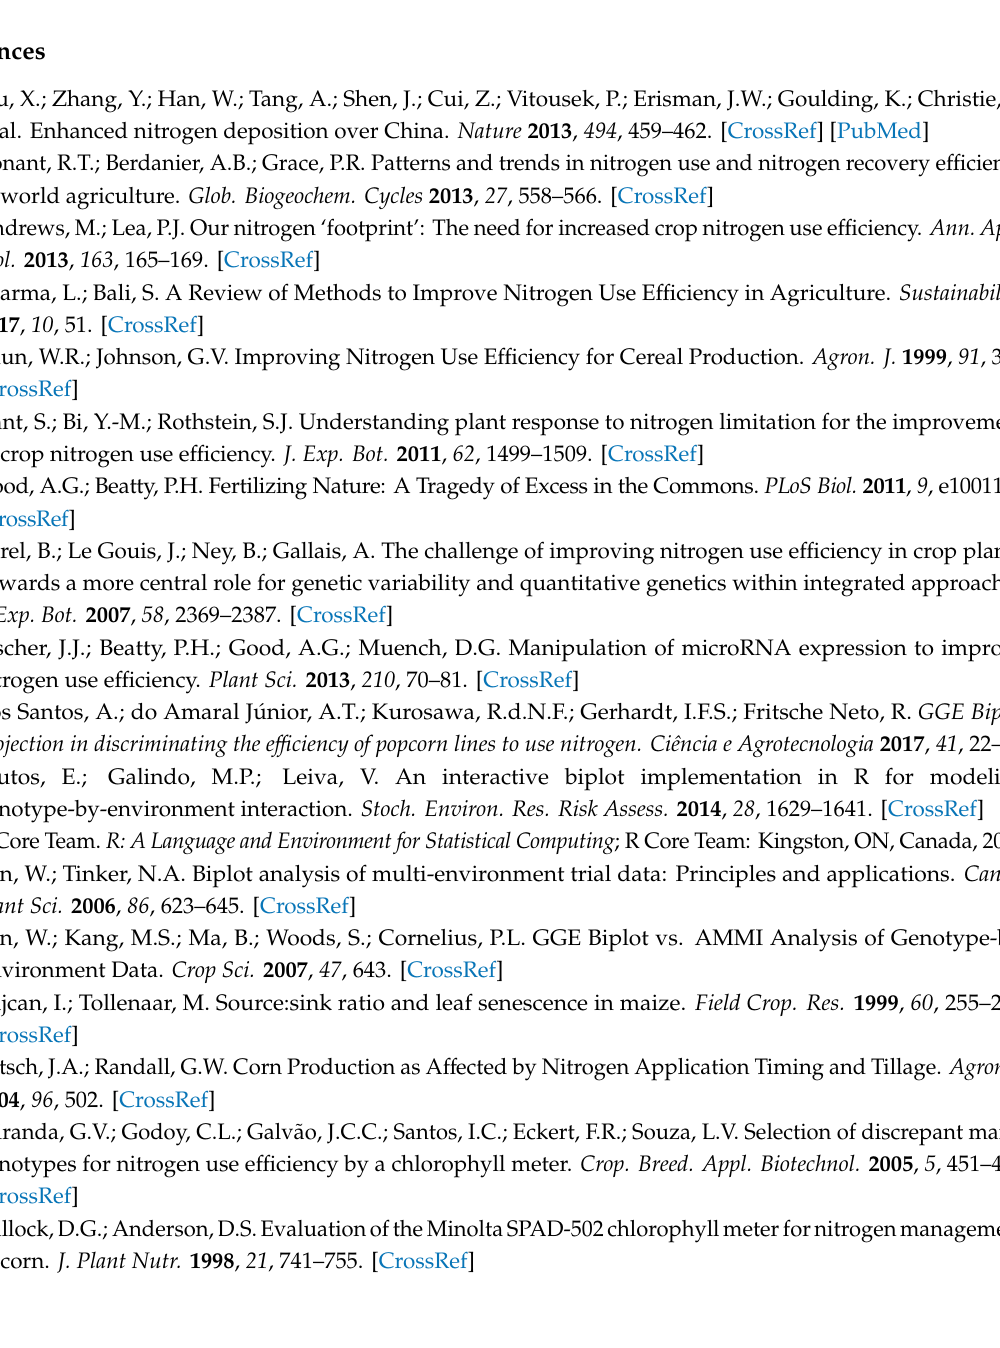
Figure S1. Pluviometric precipitation, minimum and maximum temperature, relative humidity during